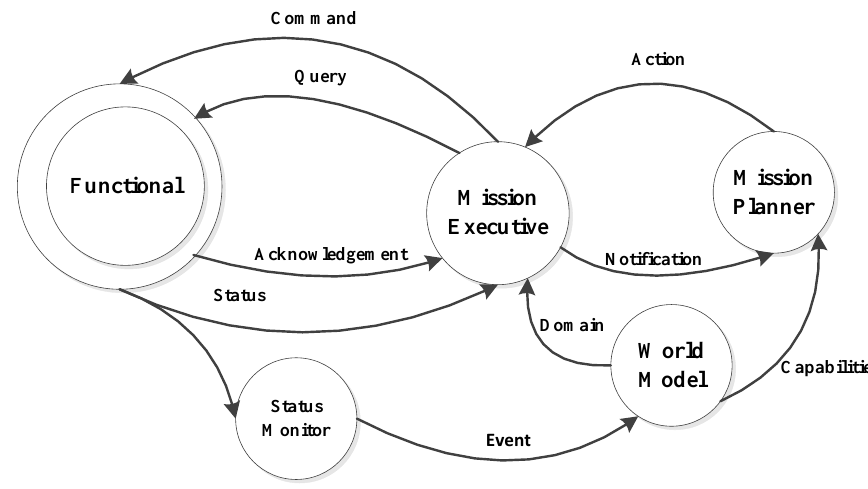
Figure 7. Semantic knowledge-based framework in Trident, as described in [41].